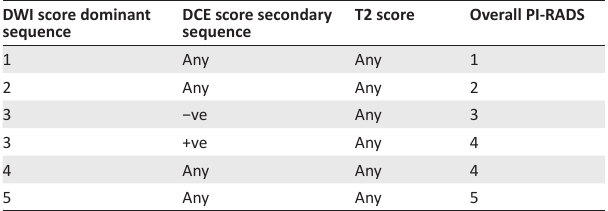
TABLE 4: Combined evaluation of peripheral zone prostatic lesions using the diffusion-weighted imaging score, dynamic contrast enhanced score and T2 score to derive the overall PI-RADS grading.